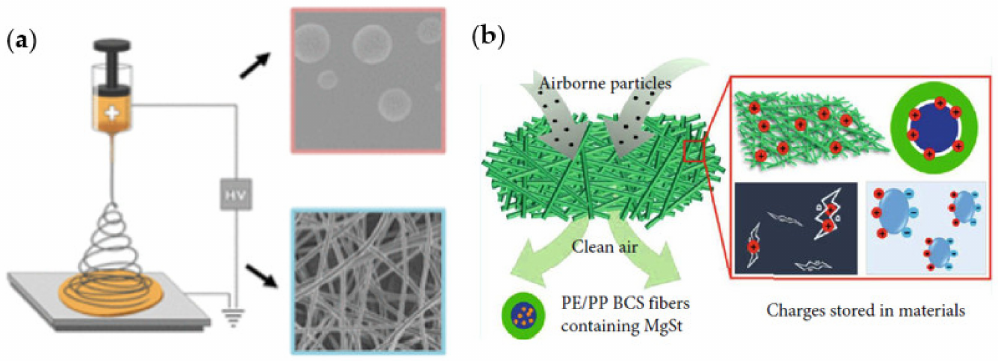
Figure 2. ( a ) Electrospinning process of polymers into fibers; ( b ) schematic of PE/PP nanofiber with magnesium stearate as charge enhancer. Reprinted with permission from [97,98]. Copyright © 2019 American Chemical